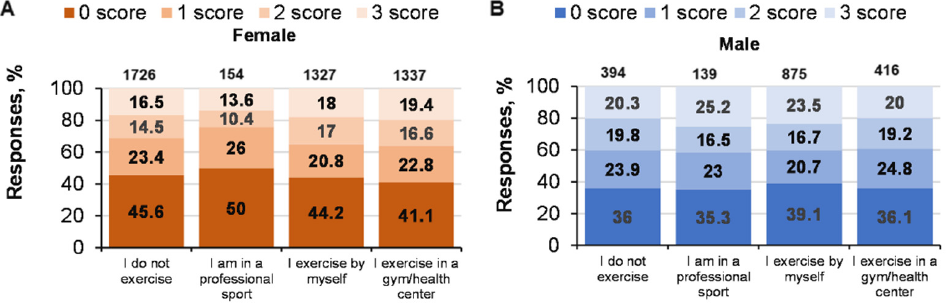
Figure 5. Solving CRT tasks and specific sporting activities. At the top of the column is the number of participants. (( A )—women CRT responses % and specific sporting activities; ( B )—men CRT responses % and specific sporting activities).